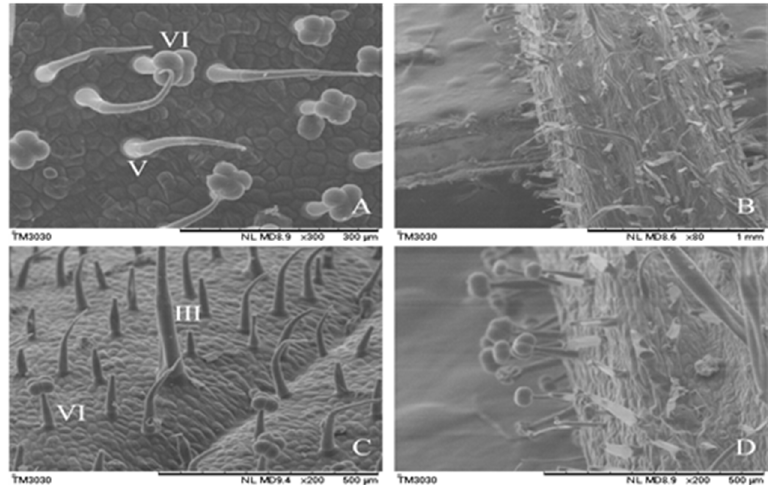
Figure 2. Morphological observation of different types of trichomes of tomato 3186 L (tomato wo mutant, hairless) under a scanning electron microscope. The gross state of the trichomes of 3186L was observed by scanning electron microscopy, and different types of trichomes are marked in the picture. Scale bars ( A ) = 300 μ m, ( B ) = 1 mm, ( C ) = 500 μ m, ( D ) = 500 μ m.